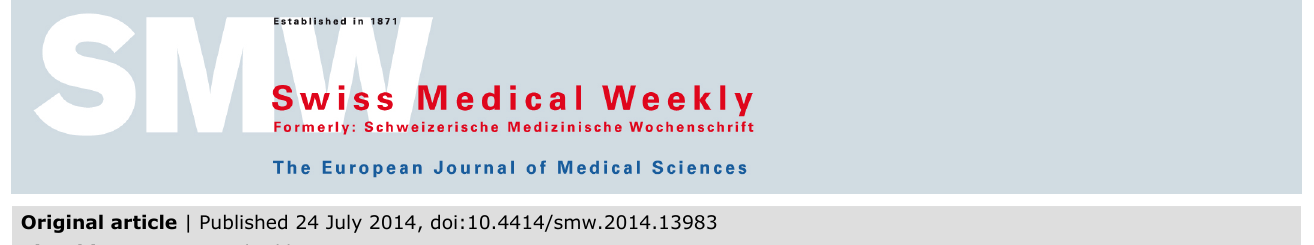
Zurich. (Figure courtesy of the Swiss Lung